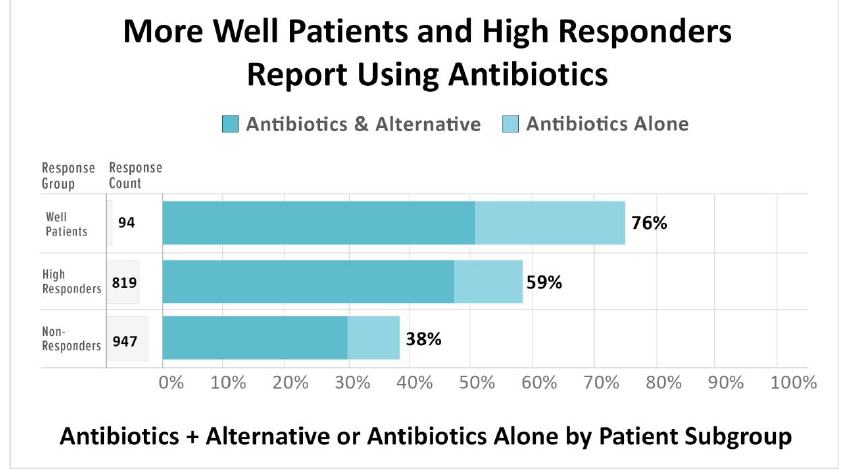
Figure 4. A greater percentage of well patients (76%) and high responders (59%) report using antibiotics or a combination of antibiotics and alternative treatments compared to nonresponders